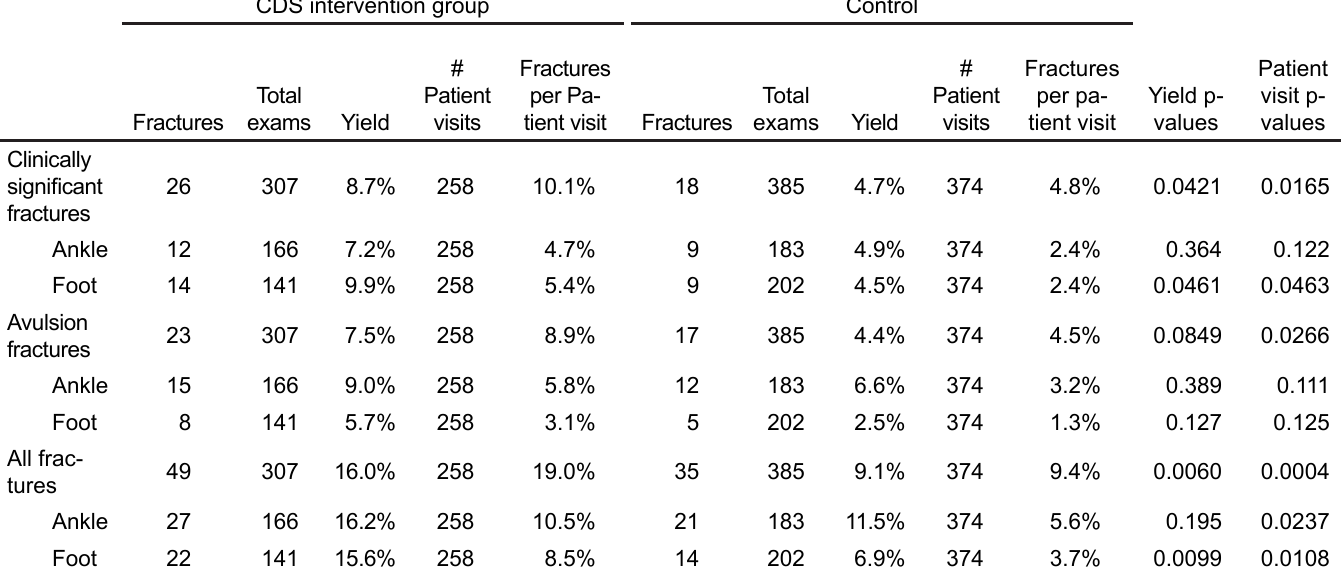
CDS, clinical decision